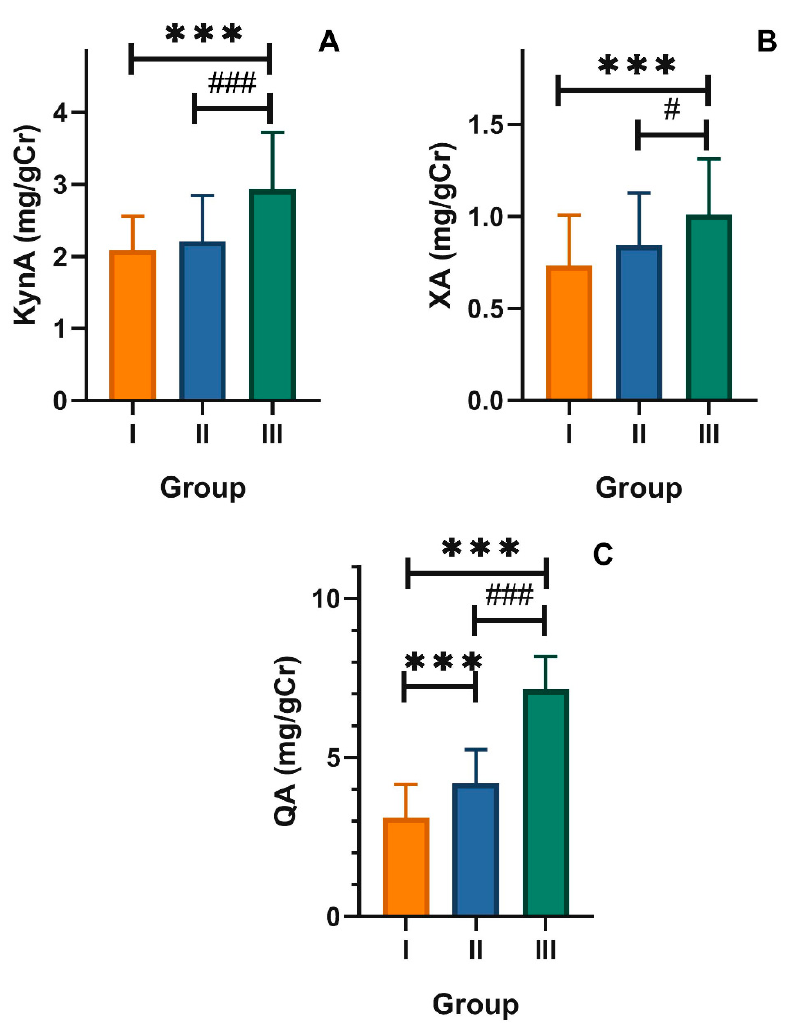
Figure 3. Urinary levels of ( A ) kynurenic acid (KynA), ( B ) xanthurenic acid (XA), and ( C ) quinolinic acid (QA) expressed in milligram per gram of creatinine (mg / gCr) in healthy young adult individuals (group I) and in the elderly without (group II) and with mood disorders (group III); mean ± SD di ff erences between groups were analyzed by ANOVA with Dunnett’s multiple comparison method (group III vs. I and group II vs. I) or contrast (group III vs. II); n = 30 in each group; *** p < 0.001; # p < 0.05; ### p <